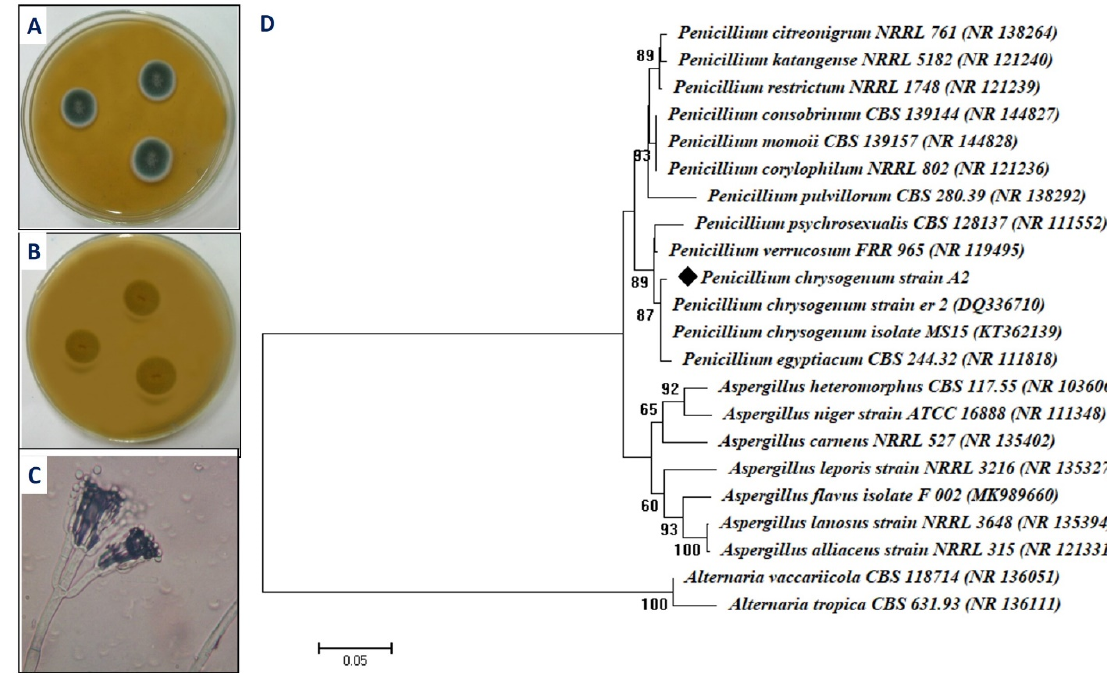
Figure 1. Cultural, microscopic, and ITS sequence analysis of fungal isolate A2. ( A ) Colony of fungal isolate A2 on malt extract agar media, ( B ) reverse colony of isolate A2 on malt extract agar media, ( C ) bright-field microscopic examination (X = 800), and ( D ) phylogenetic tree of isolate A2 with the sequences from NCBI. The symbol (cid:117) refers to ITS fragments retrieved from this study. The tree was conducted with MEGA 6.1 using the neighbor-joining method.